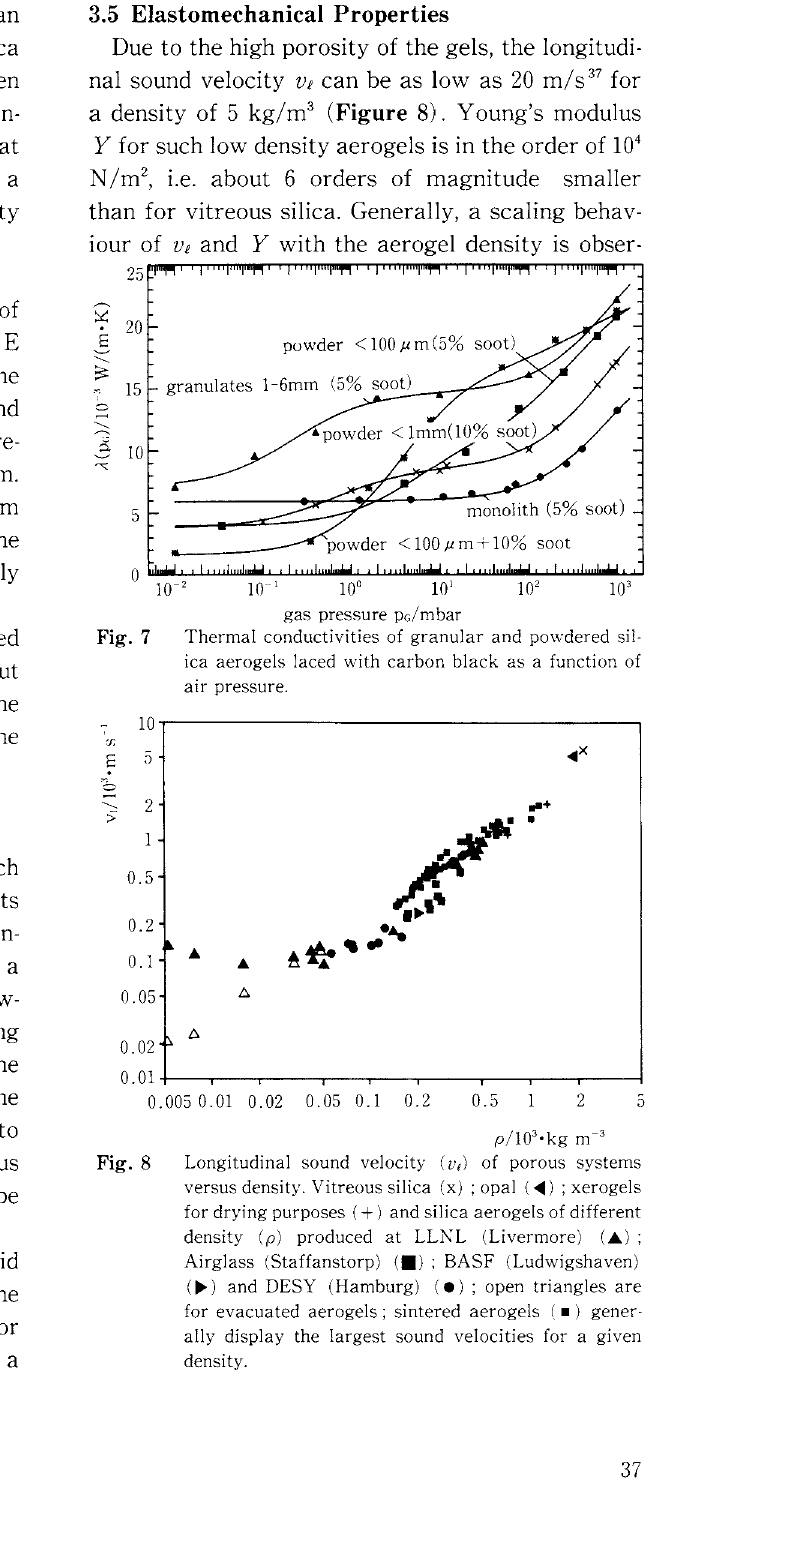
Longitudinal sound velocity ( u,) of porous systems versus density. Vitreous silica (x) ; opal (<Ill) ; xerogels for drying purposes ( +) and silica aerogels of different density (p) produced at LLI\L (Livermore) (A) ; Airglass (Staffanstorp) (•) ; BASF (Ludwigshaven) ( ~) and DESY (Hamburg) ( •) ; open triangles are for evacuated aerogels; sintered aerogels ( •) gener· ally display the largest sound velocities for a given